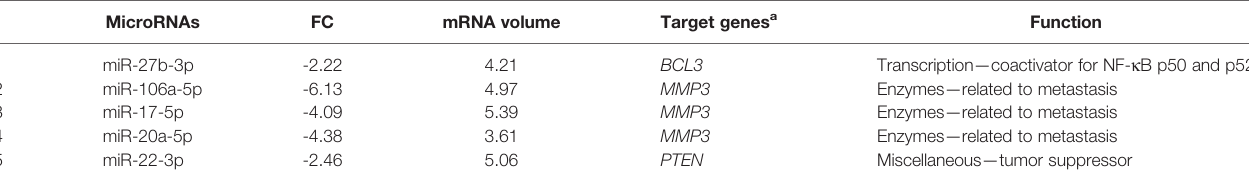
ffiffiffiffiffiffiffiffiffiffiffiffiffiffiffiffiffiffiffiffiffiffiffiffiffiffiffiffiffiffiffiffiffiffiffiffiffiffiffiffiffiffiffiffiffiffiffiffiffiffiffiffiffiffiffiffiffiffiffiffiffiffiffiffiffiffiffiffiffiffiffiffiffiffiffiffiffiffiffiffiffiffiffiffiffiffiffiffiffiffiffiffiffiffiffiffiffiffiffiffiffiffi p normalized control value (cid:1) normalized DPG value